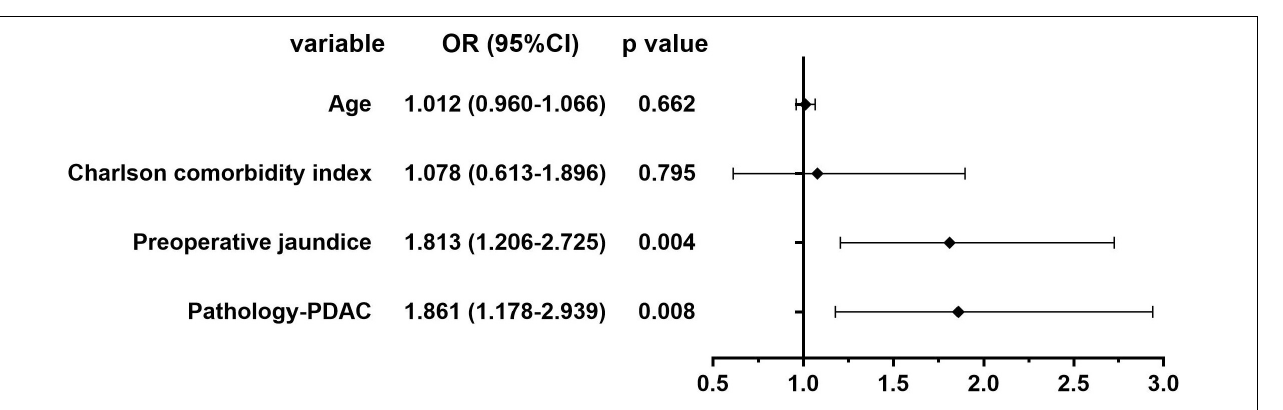
FIGURE 3 | Multivariate analysis of the risk factors of preoperative anemia in all